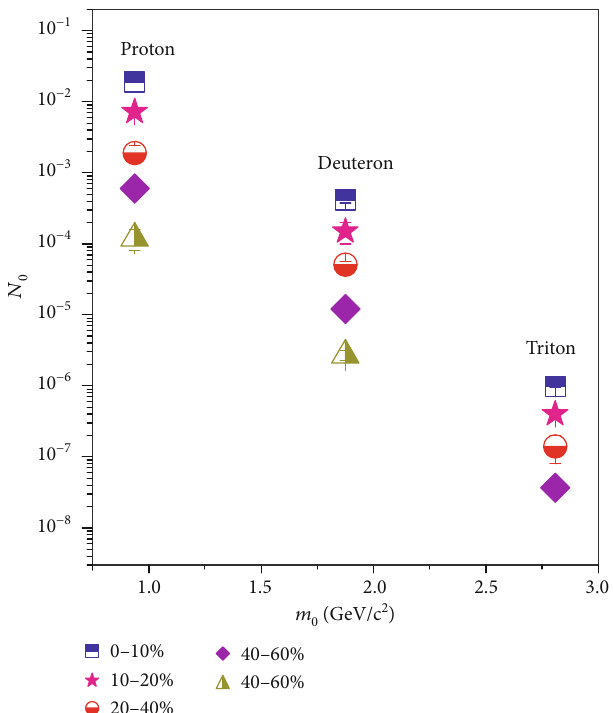
Figure 8: Dependence of N